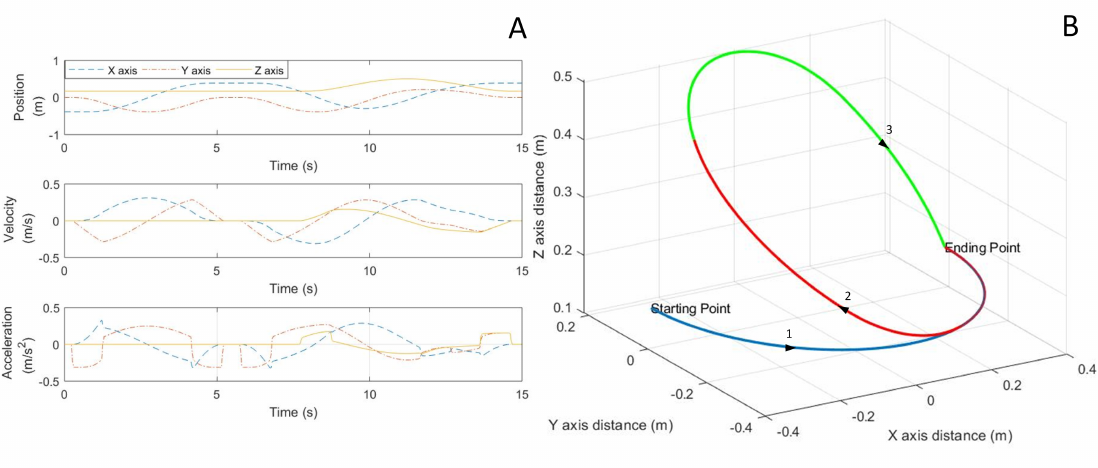
Figure 4. The designed trajectory for the end effector mass. ( A ) Position, velocity, and acceleration of end effector in X, Y, and Z components. ( B ) Positions of the end effector in